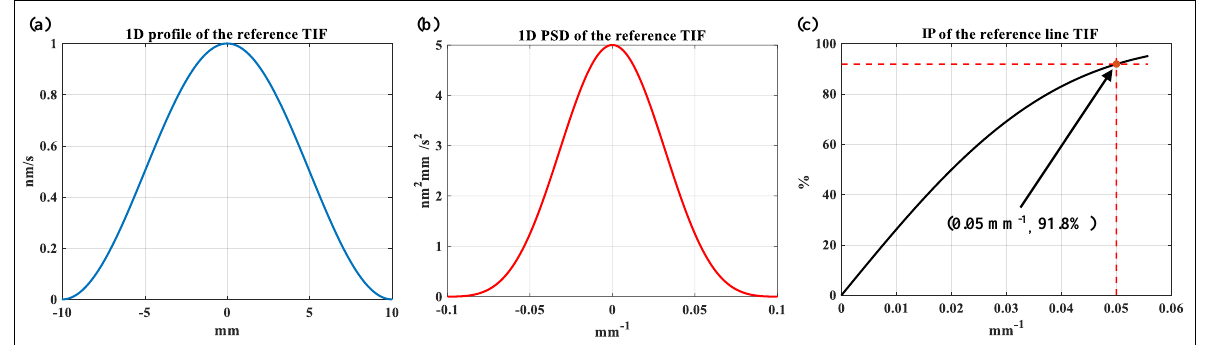
= 0.05 mm − 1 , ( b ) 1D PSD of the TIF